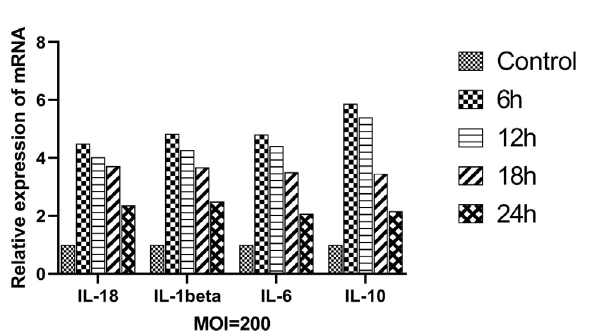
Fig. 4. Effect of S.suis2 infection on the expression of cytokines (MOI =